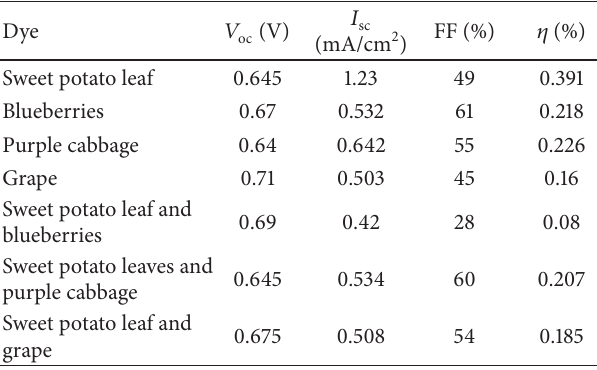
Table 2: The performance of DSSCs using natural dyes at a weight concentration of 20%.